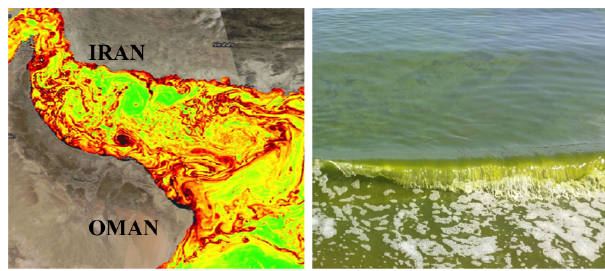
Figure 12. (a) NOAA Suomi-VIIRS-derived Chl a concentrations on 6 February 2018 showing Noctiluca blooms in the Sea of Oman in association with a cyclonic eddy. For projecting the Chl a con- centrations the Google Earth low-resolution land elevation map was used (© Google Earth). (b) Noctiluca blooms along the coast of Muscat on 6 February